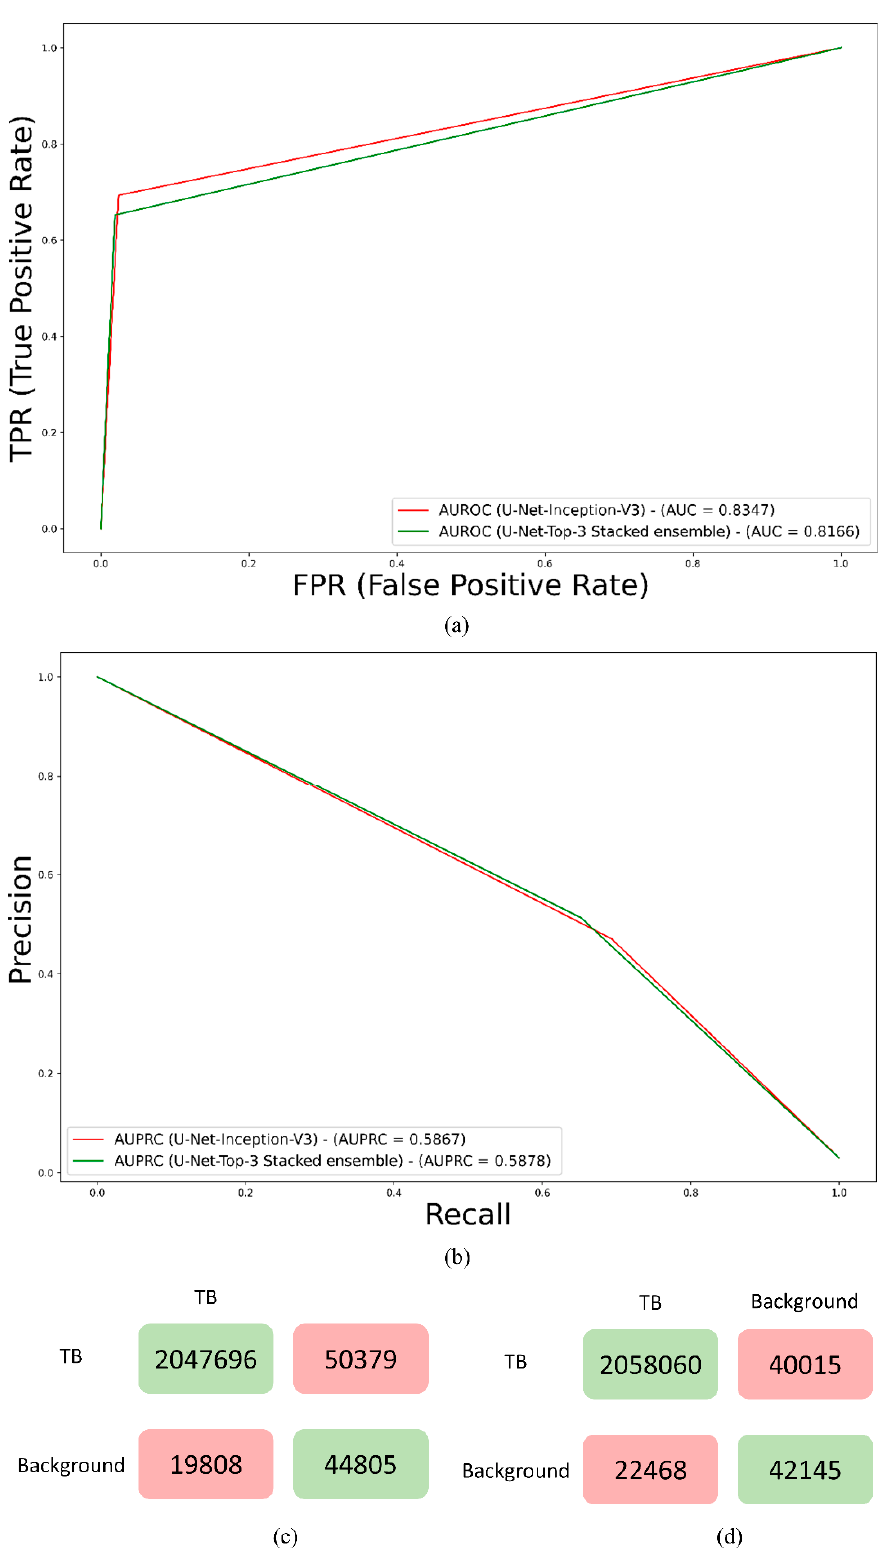
Figure 5. Performance of the U-Net with Inception-V3 encoder backbone and the stacking ensemble constructed using the top three performing models trained on original CXRs. ( a ) ROC curves; ( b ) PR curves; ( c ) Confusion matrix achieved with Inception-V3 encoder backbone, and ( d ) Confusion matrix achieved with the stacking ensemble.